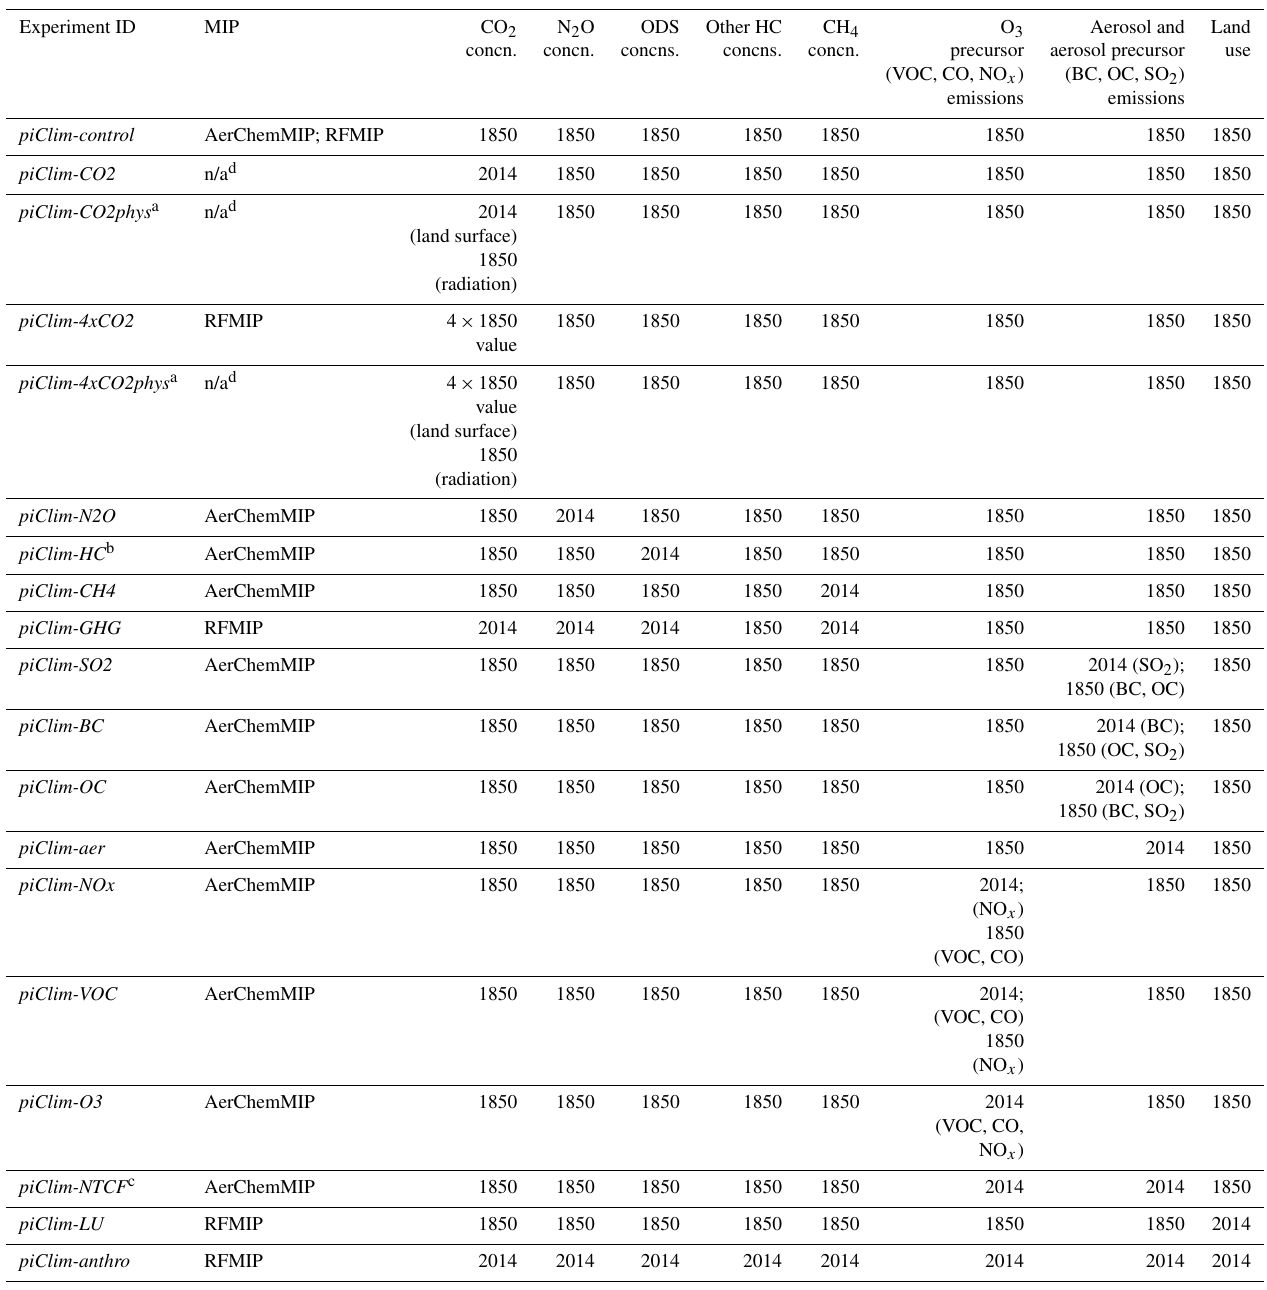
Table 1. List of all the atmosphere-only experiments carried out with the UK’s Earth System Model, UKESM1, to quantify PD ERFs from PD–PI changes in emissions, concentrations, and/or land use. Each simulation was 45 years in length, with analysis based on the last 30